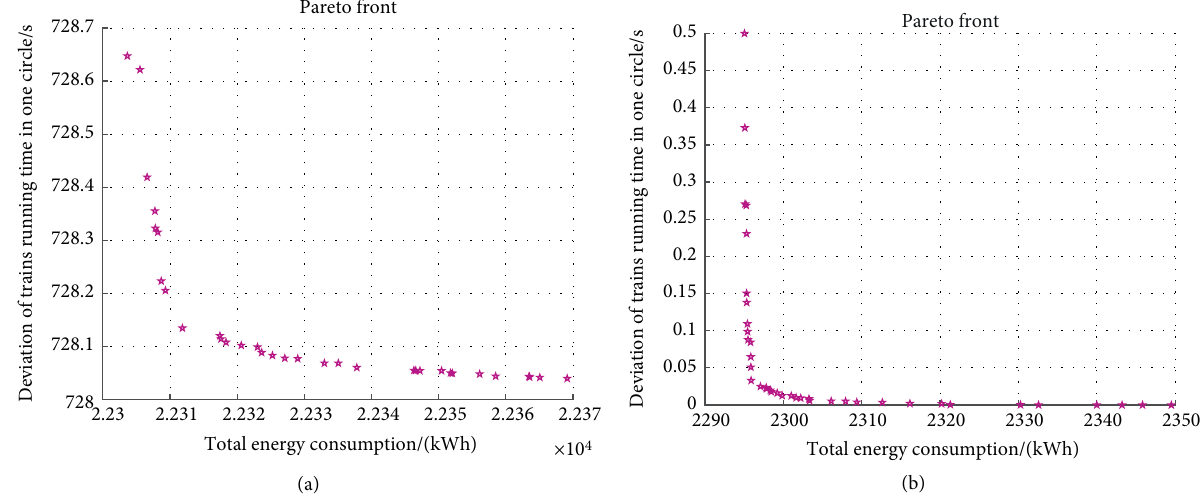
Figure 20: The Pareto front under and OIC = 0.4. (a) The Pareto solutions of the OEST. ( b ) The Pareto solutions of the OQOST. 𝐺 = 200